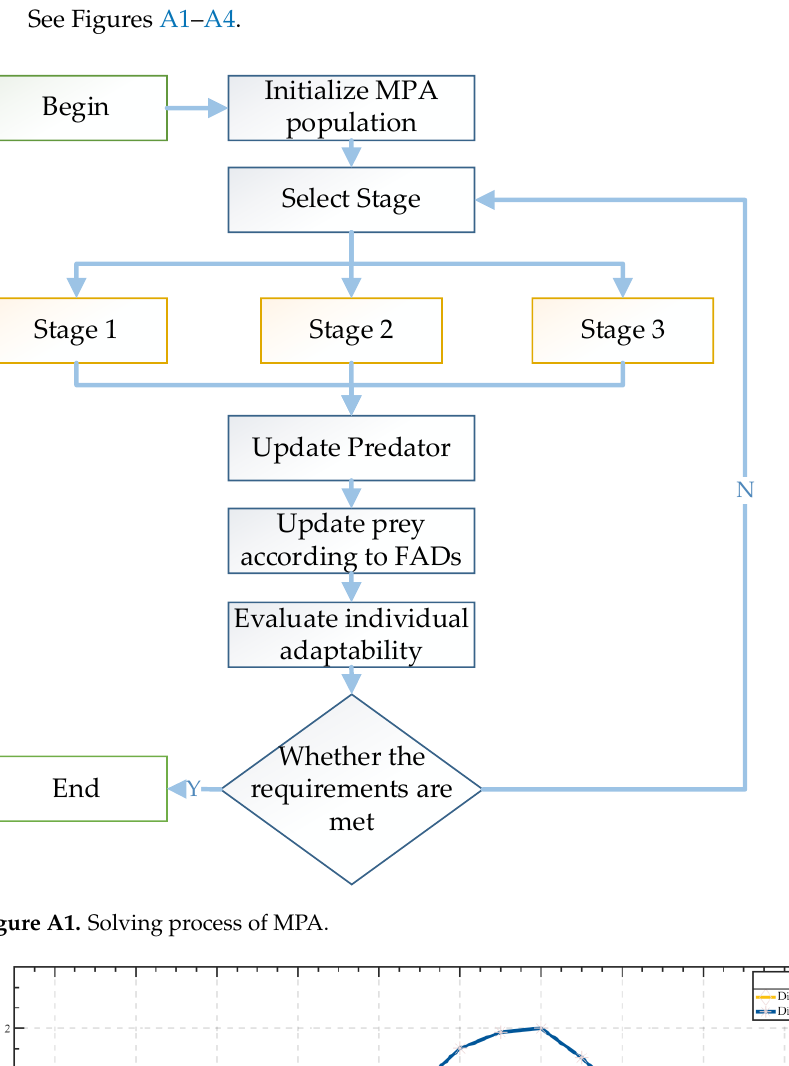
Figure A1. Solving process of MPA.